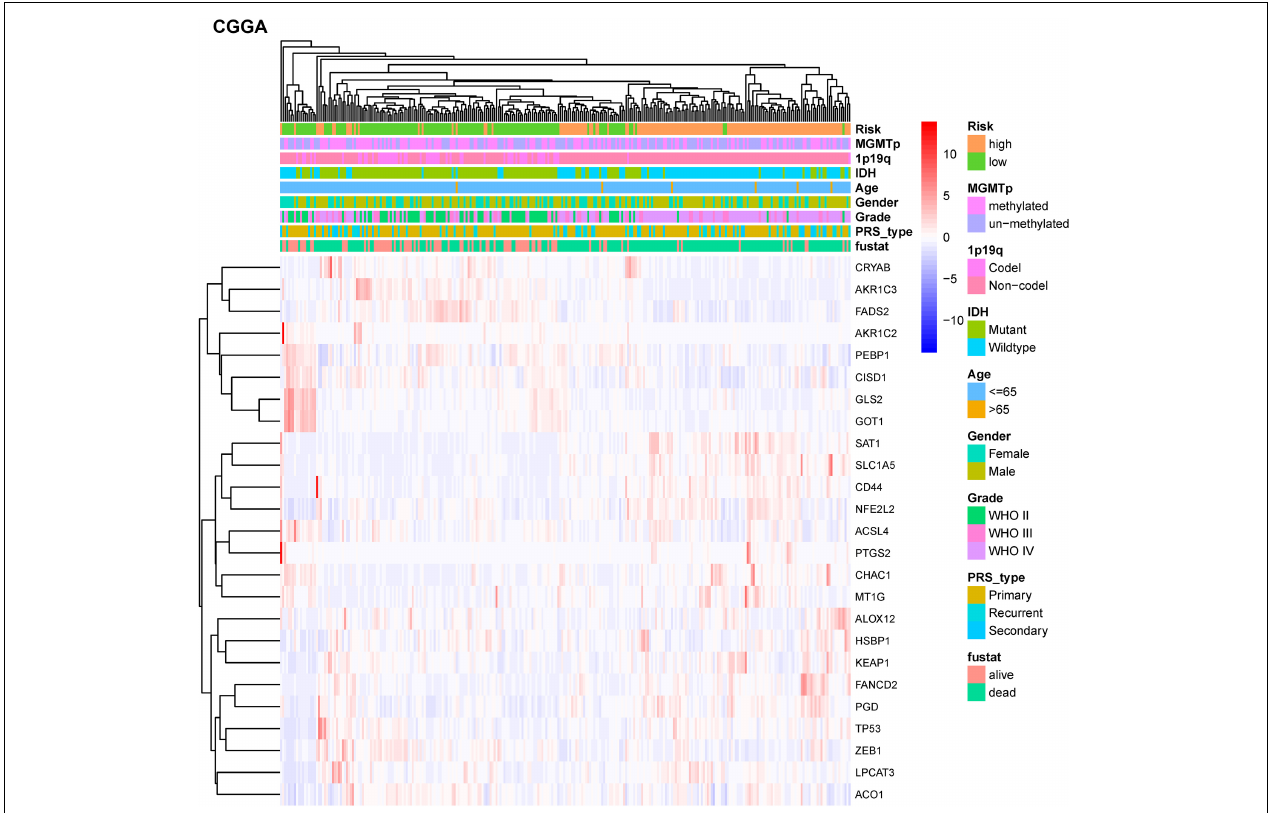
FIGURE 5 | Hierarchical clustering showing correlation between signature risk score, different expression levels of selected ferroptosis-related genes, and clinical or molecular features in the CGGA dataset. Heatmap showed the different expression levels of 25 ferroptosis-related genes and clinical or molecular pathological features using hierarchical clustering in CGGA dataset. Methylguanine methyltransferase promotor (MGMTp); isocitrate dehydrogenase (IDH); co-deletion (Codel); without co-deletion (Non-codel); primary/recurrent/secondary type of glioma (PRS_type); survival status (fustat).